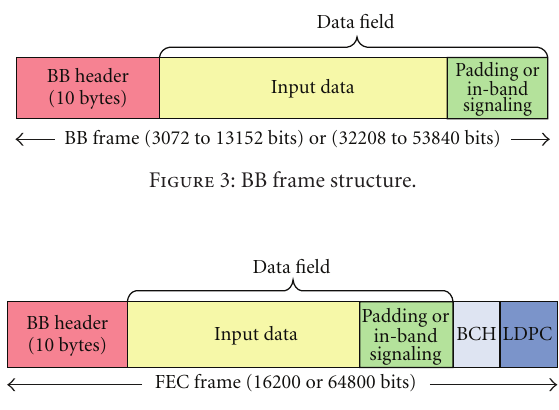
Figure 4: FEC frame